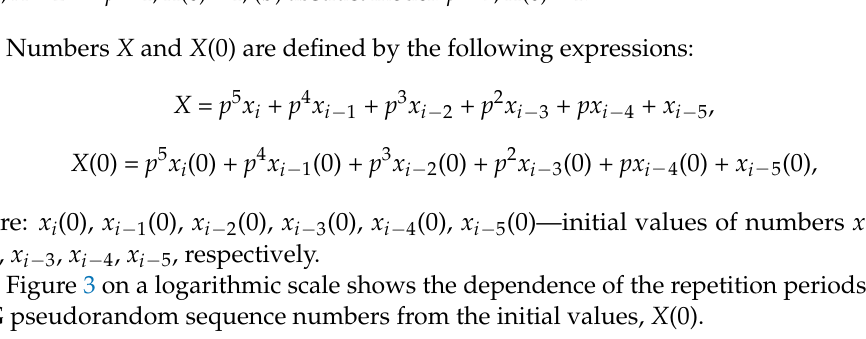
Figure 2. Current values of pseudorandom numbers X (for AFG): ( а ) hardware model: p = 7, n = 3, A = 2 n − p = 1, X (0) = 1; ( b ) abstract model: p = 7 , X (0) = 1.